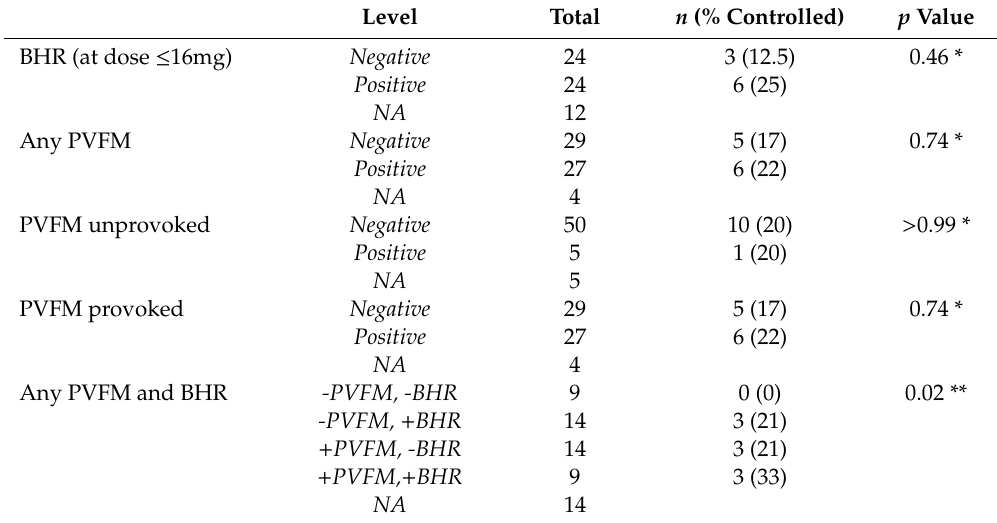
Table 4. Airway hyper-responsiveness measured by bronchial hyper-reactivity (BHR) and paradoxical vocal fold movement (PVFM) in Uncontrolled and Controlled participants (n = 60). Level Total n (% Controlled) p Value BHR (at dose ≤ 16mg) Negative 24 3 (12.5) 0.46 * Positive 24 6 (25) NA 12 Any PVFM Negative 29 5 (17) 0.74 * Positive 27 6 (22) NA 4 PVFM unprovoked Negative 50 10 (20) > 0.99 * Positive 5 1 (20) NA 5 PVFM provoked Negative 29 5 (17) 0.74 * Positive 27 6 (22) NA 4 Any PVFM and BHR -PVFM, -BHR 9 0 (0) 0.02 ** -PVFM, + BHR 14 3 (21) + PVFM, -BHR 14 3 (21) + PVFM, + BHR 9 3 (33) NA